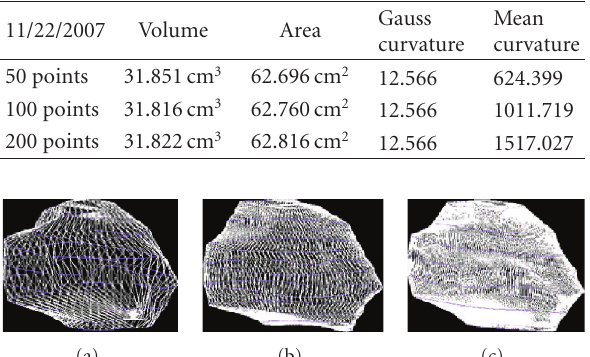
Figure 27: Patient 2. (a) 50 points on the contours, (b) 100 points on the contours, and (c) 200 points on the